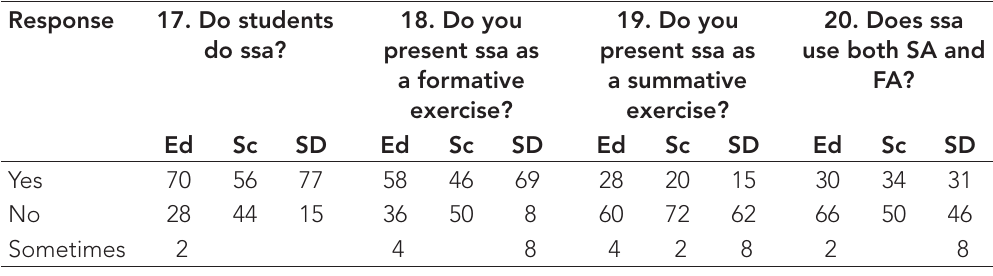
Table 8: Information on student self-assessment (ssa) Response